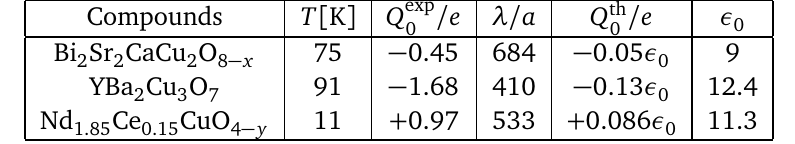
is extracted from 0 , of Eq. 39, is fit to 0